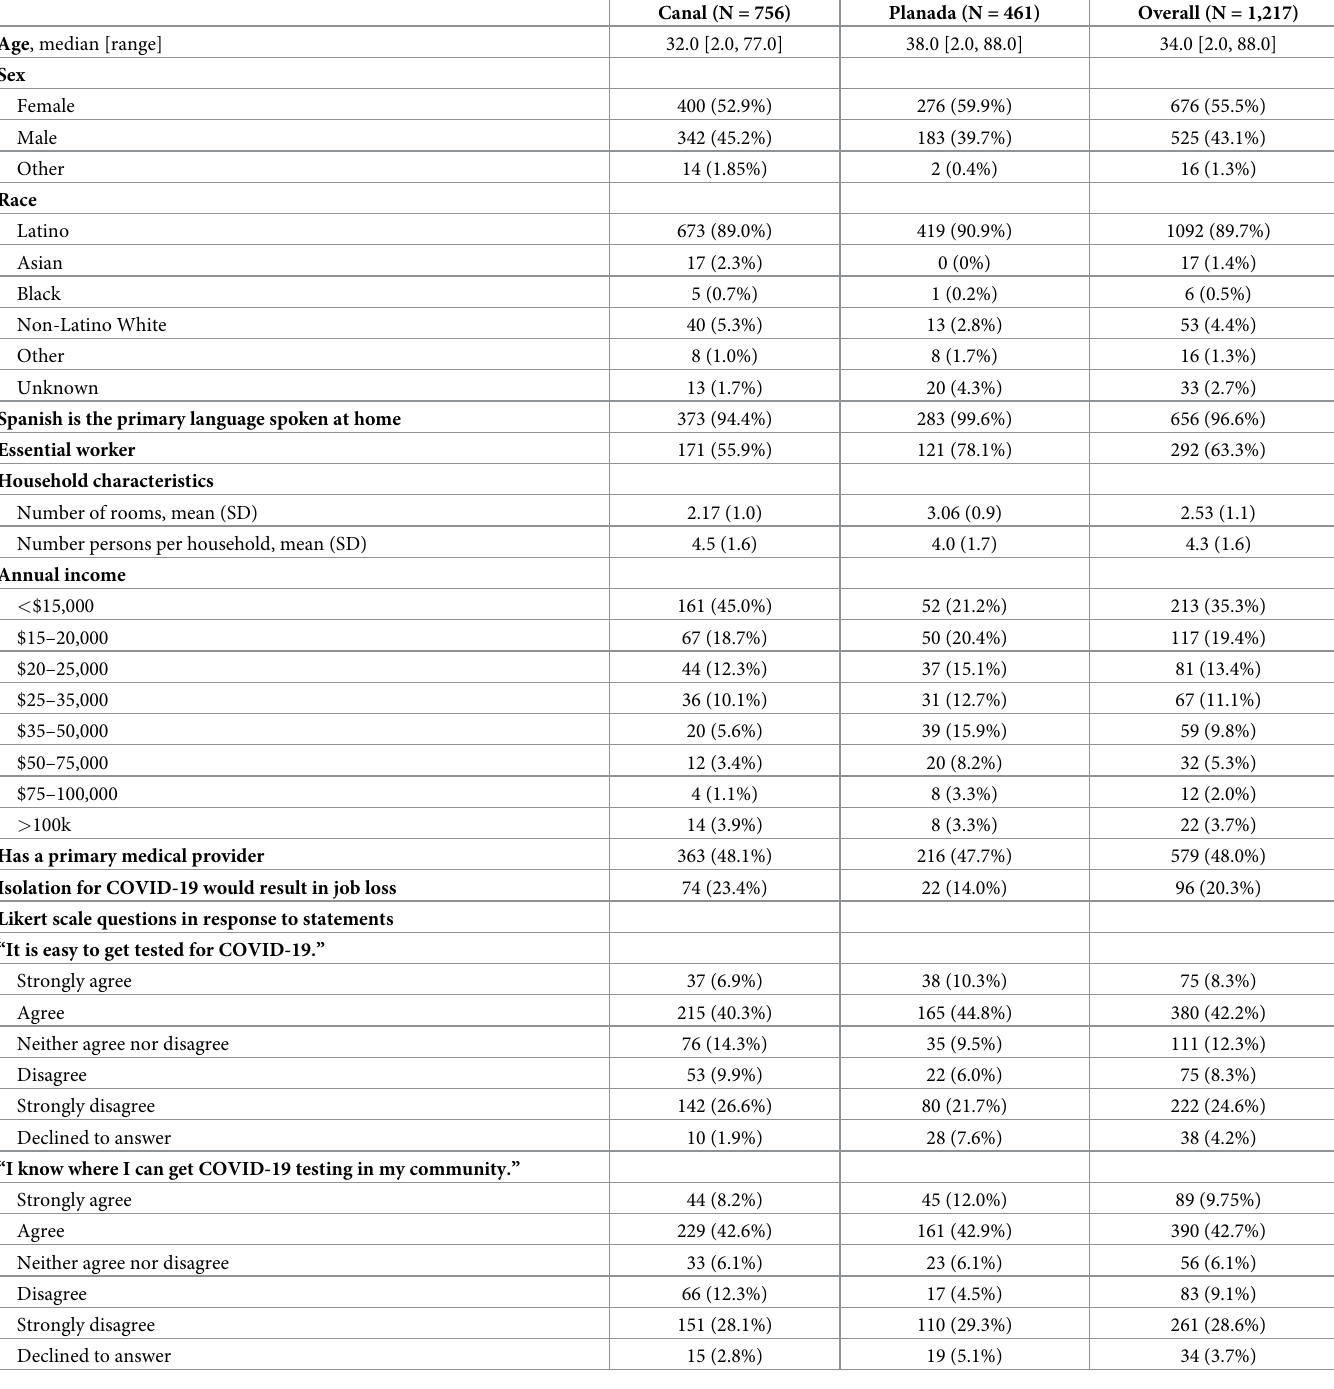
Table 1. Characteristics of mass COVID-19 “test and respond” event attendees from March-April 2021in two predominantly Latino, low-income communities in Northern